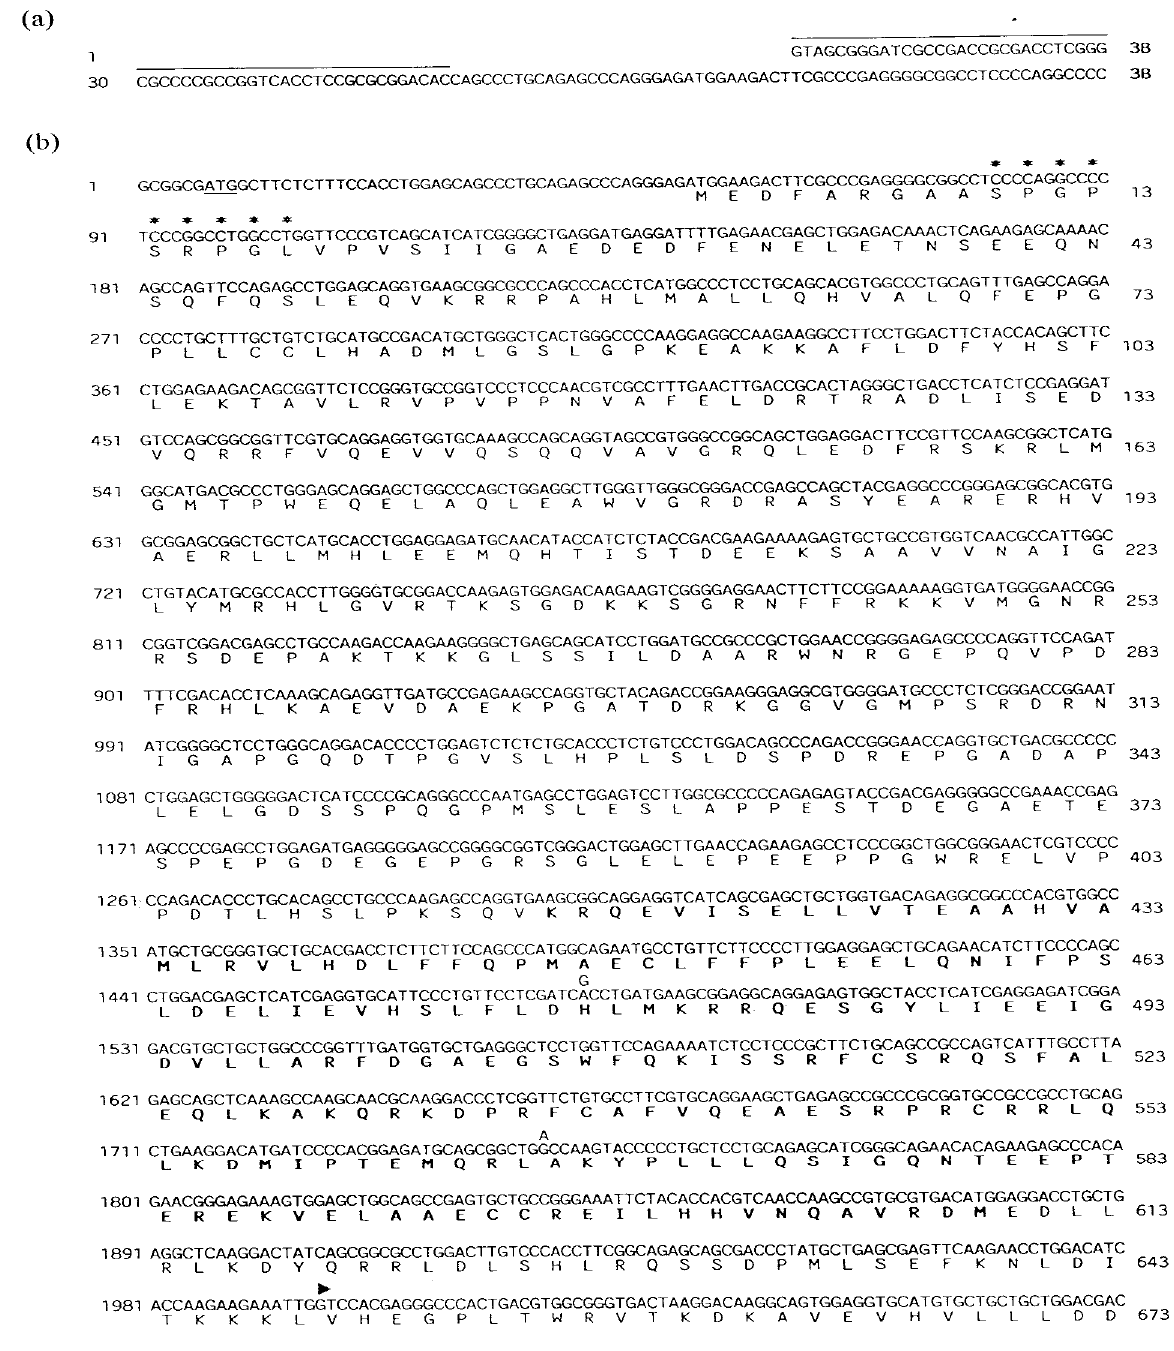
Fig. 2. (a) The alternative 5 9 sequence from clone 3B and (b) the nucleotide and predicted amino acid sequence of the lip cDNA clone 11A. 5 9 RACE analysis has demonstrated the presence of an additional 18-bp 5 9 sequence, GAGGCTTCGGTTCCGGTG, which is missing from clone 11A. The amino acid sequence commences at the second Kozak methionine at nucleotide position 52. The ® rst methionine at position 7 (absent from clone 3B) is underlined, the divergent sequence in clone 3B is overlined. The amino acid substitutions within the DBL homology (DH) domain, introduced by the mismatches between clone 11A and the transfectant clones, are shown above the nucleotide sequence, A ® G at nucleotide 1481, G ® A at nucleotide 1747. The DH domain is shown in bold. The PH domain is ¯ anked by arrowheads, potential SH3 domain-binding sites are marked by asterisks above the sequence. The positions at which 11A sequence and the sequence in clones T1, T3 diverge are marked with arrows. The stop codon TGA is marked with an asterisk below the sequence. Nucleotide sequence is numbered on the left and amino acid sequence on the right. (c) Nucleotide and predicted amino acid sequence of the 3 9 end of transfectant cDNA clone T1. The nucleotide and predicted amino acid sequences are numbered with respect to clone 11A, and sequence common to both clones 11A and T1 is underlined. An arrowhead marks the site of the rearrangement which replaces 188 amino acids from the predicted lip protein with 15 novel residues. The in-frame stop codon is marked with an asterisk. (d) Nucleotide and predicted amino acid sequence of the 3 9 end of transfectant clone T3. Nucleotide and amino acid sequences are numbered with respect to clone 11A, and sequences common to both clone 11A and T3 are marked with arrowheads and underlined. The in-frame stop codon is marked with an asterisk. The rearrangement in clone T3 replaces 217 amino acids at the 3 9 end of clone 11A with a single novel